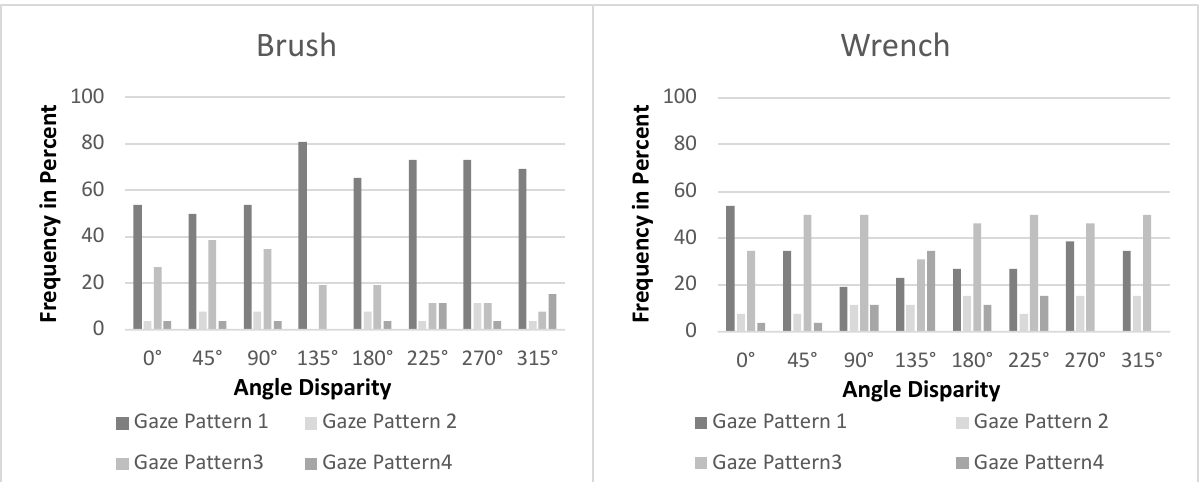
Figure 7: The frequency in percent of usage of the different gaze patterns separately for wrench and brush. Gaze pattern and performance. With regard to performance, it can be assumed that the different gaze patterns or solution strategies lead to different success